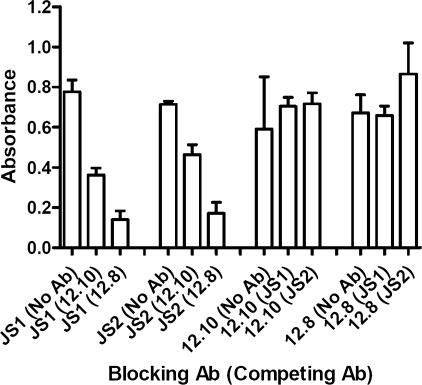
Inhibition of Binding of mAbs 12.10 and 12.8 by Fully Human Anti-MSP119 IgG1s (JS1 and JS2) by Competition ELISAThe binding of 12.8 is reduced by over 60% and the binding by 12.10 reduced by 30% suggesting that JS1 and JS2 compete with mAbs 12.8 and 12.10 for similar or overlapping epitopes. mAb 12.8, JS1, and JS2 were used at 0.5 μg/ml and mAb 12.10 at 0.05 μg/ml. Similar results were also observed when saturating concentrations of antibodies were used.